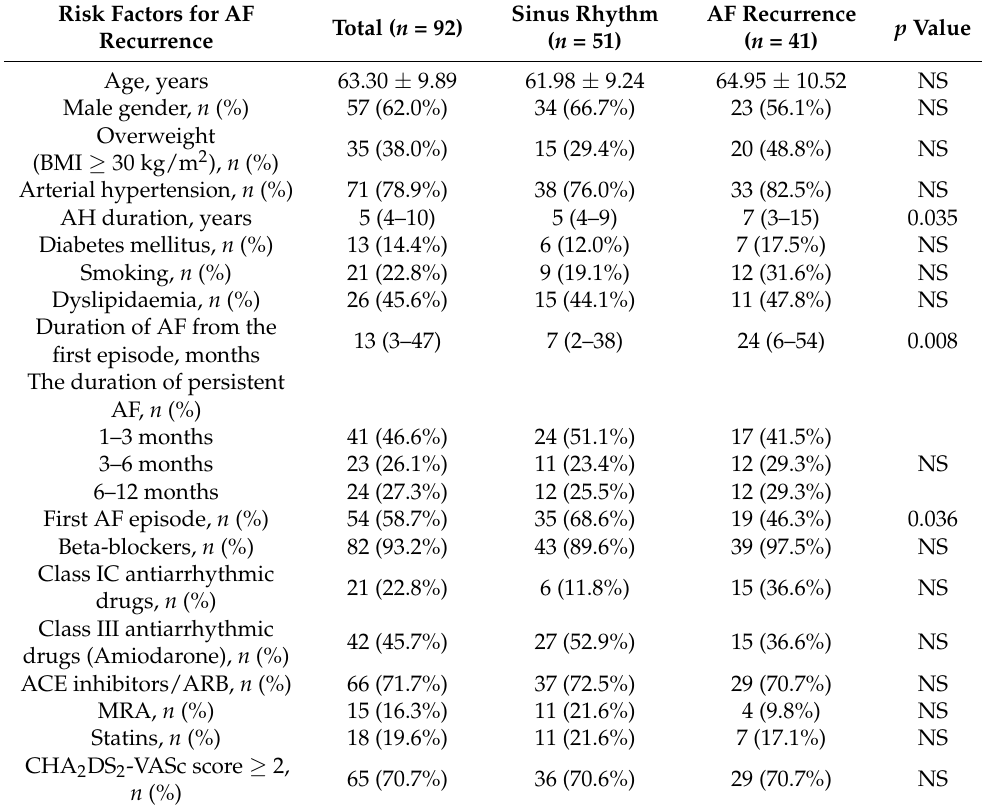
Table 1. Demographic characteristics of the